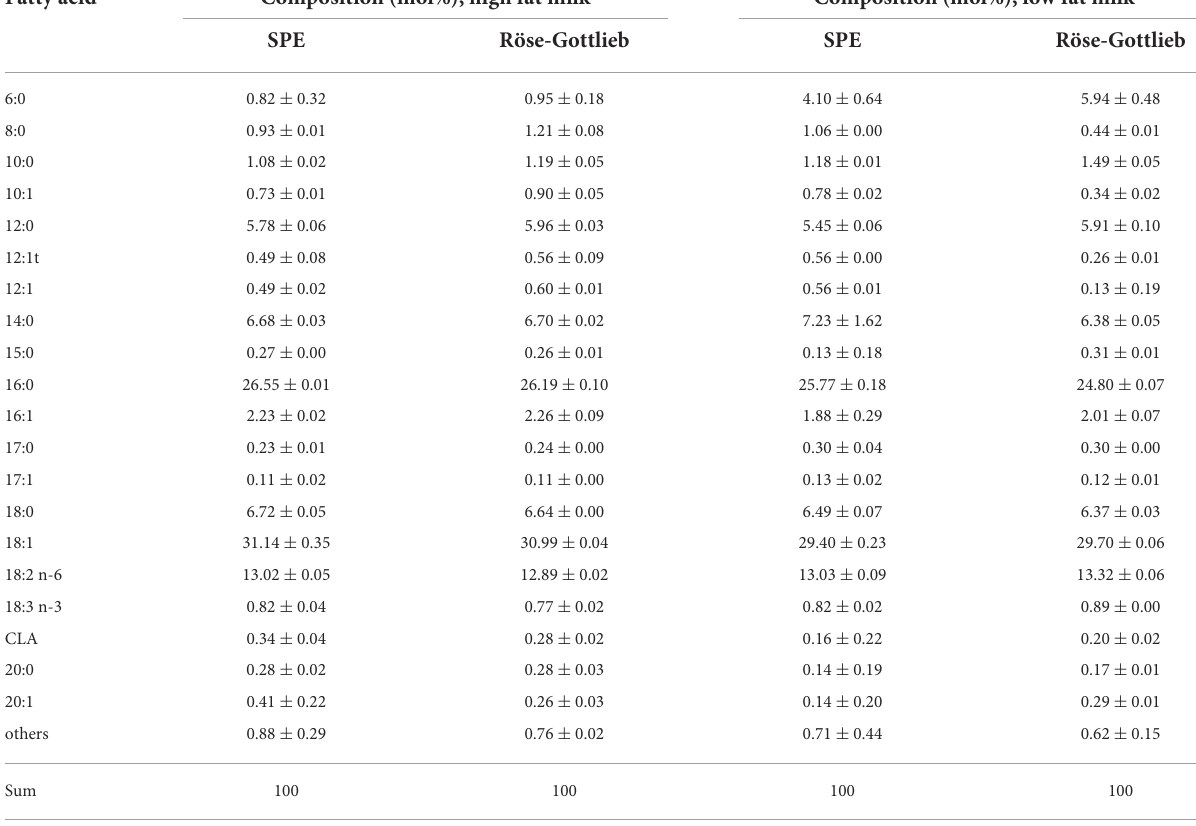
TABLE 3 FA composition of lipid (TAG) extracted by SPE or Röse-Gottlieb method from human